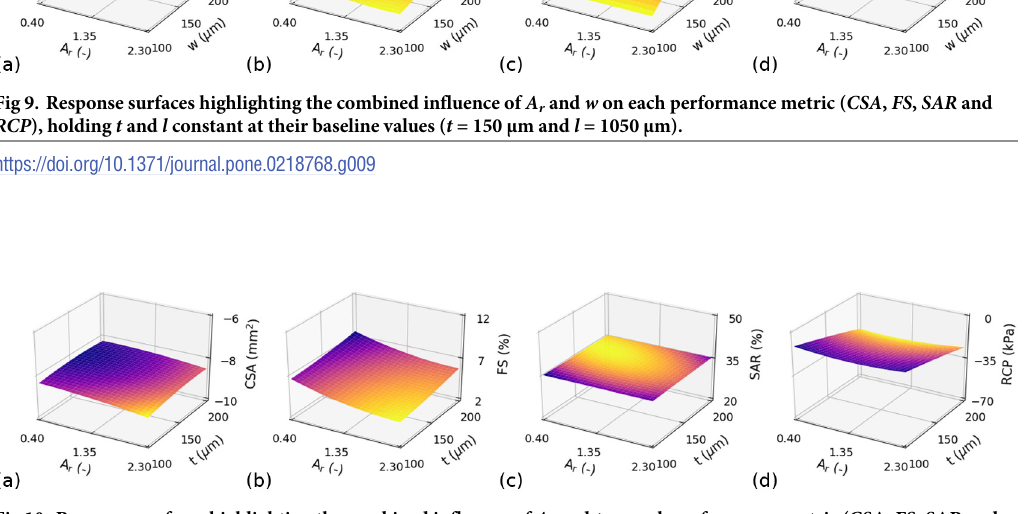
Fig 10. Response surfaces highlighting the combined influence of A r and t on each performance metric (CSA, FS, SAR and RCP), holding w and l constant at their baseline values ( w = 150 μ m and l = 1050 μ m).